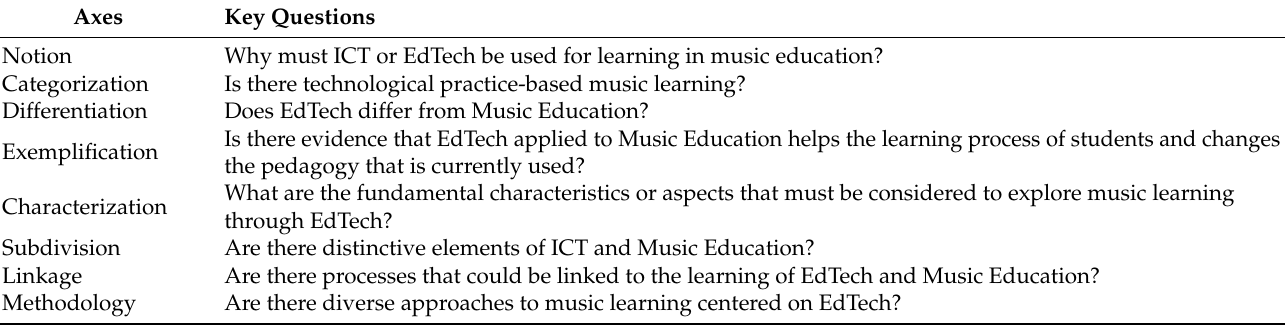
Table 1. Axes of conceptual cartography with their respective questions.